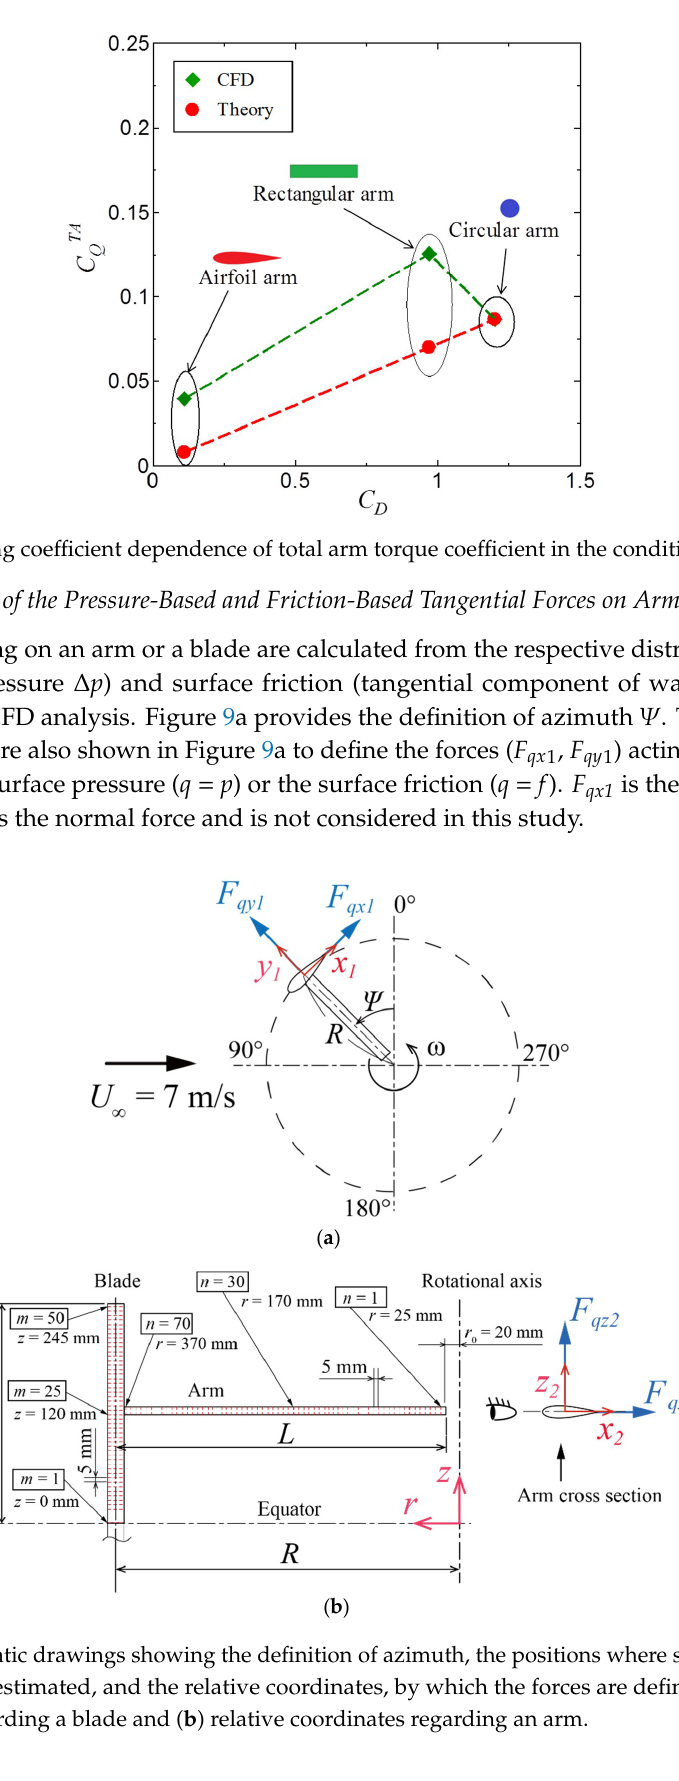
Figure 8. Drag coefficient dependence of total arm torque coefficient in the condition of λ = 3.